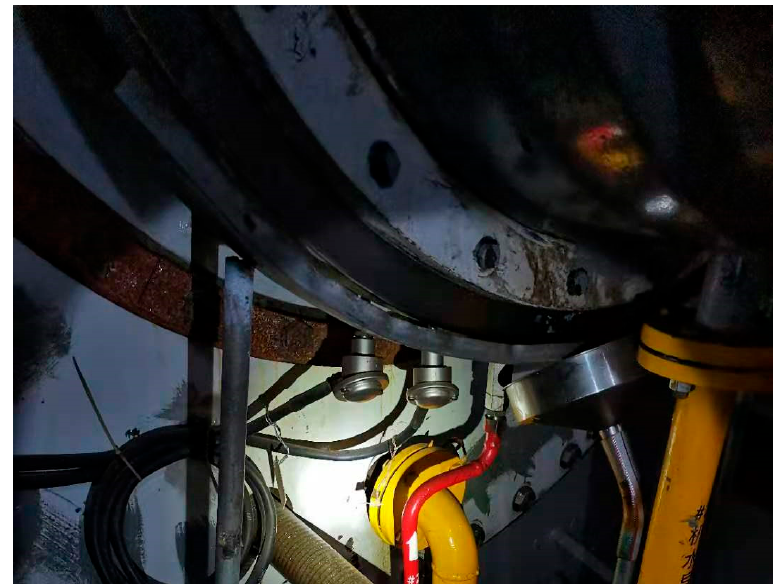
Figure 3. The installation position of RTZ bearing bush temperature sensors for collecting the temperature of water guide bearing bushe. Table 2. The main sensors used in the monitoring system. Table 4. Correlation analysis results of the partial condition monitoring parameters using maximum information coefficient (MIC), Pearson correlation (PCC), and grey correlation degree